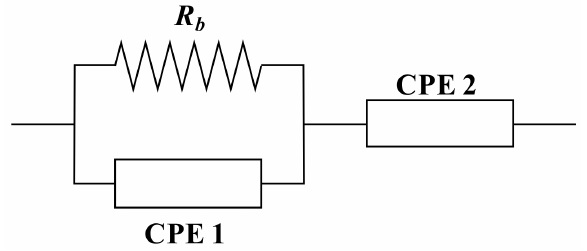
Figure 8. The equivalent electrical circuit (EEC).